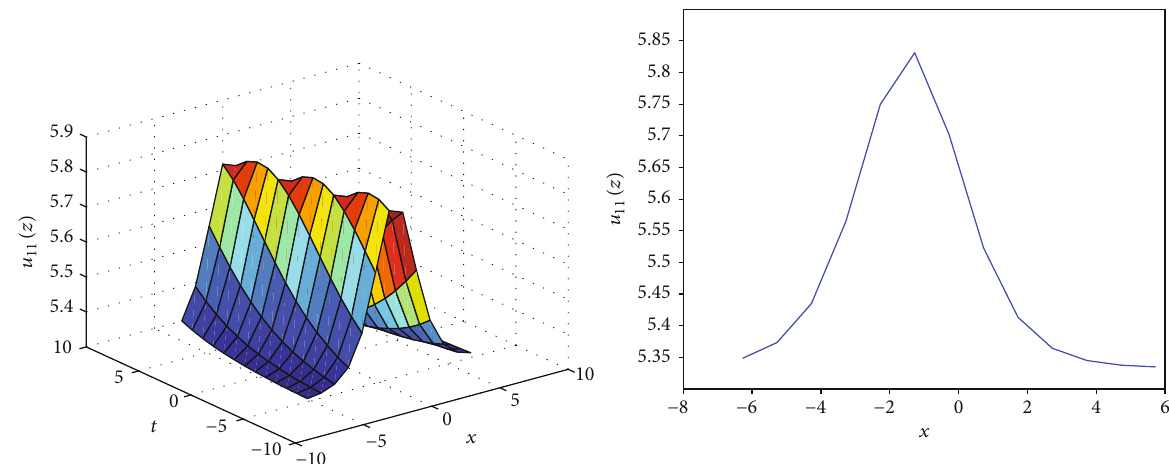
ð z Þ by choosing the values γ = 5 , ϑ = 6 , λ = 1 , ω = 1/4 , c = 1 , and t = 0 for the 2D graphic. Figure 1: The 3D and 2D graphics of u 11